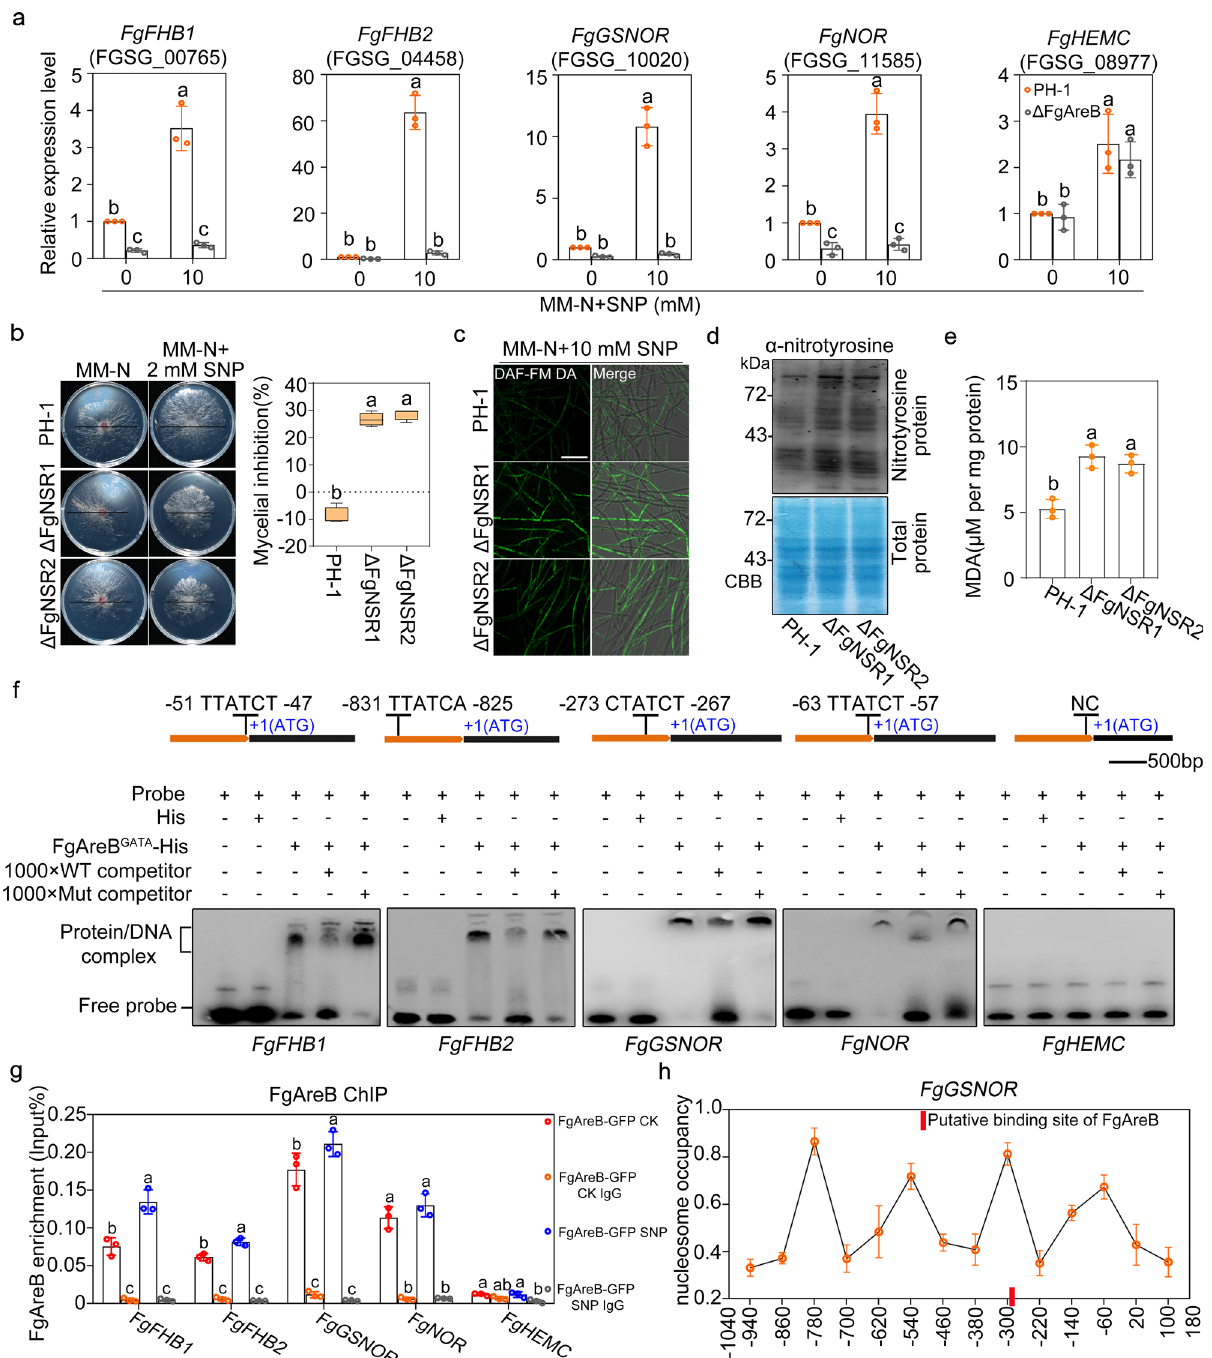
(FgSwp73, FgArp7, FgSnf6, and FgSnf2) were not,